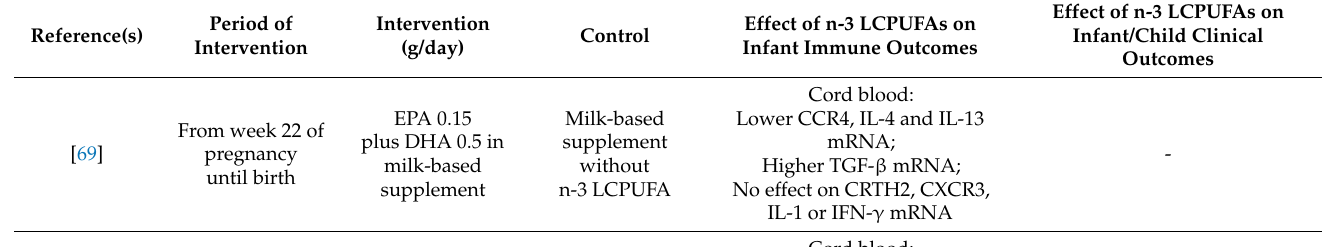
Table 2. Summary of randomised controlled trials of n-3 LCPUFAs in pregnant and/or lactating women reporting on immune and related illness outcomes in the